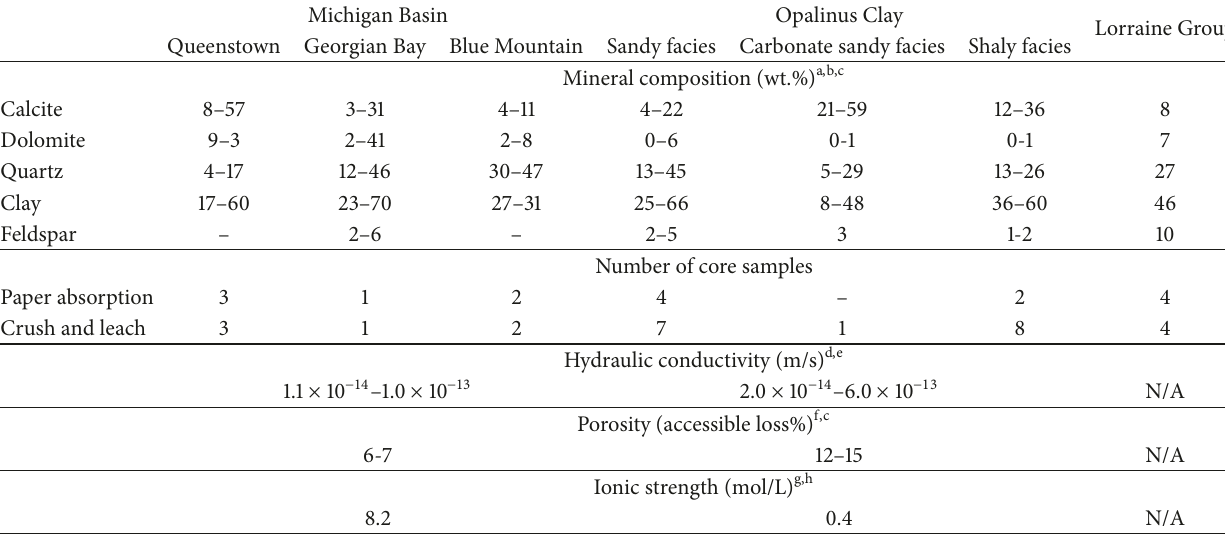
Table 1: Mineralogical and Physical